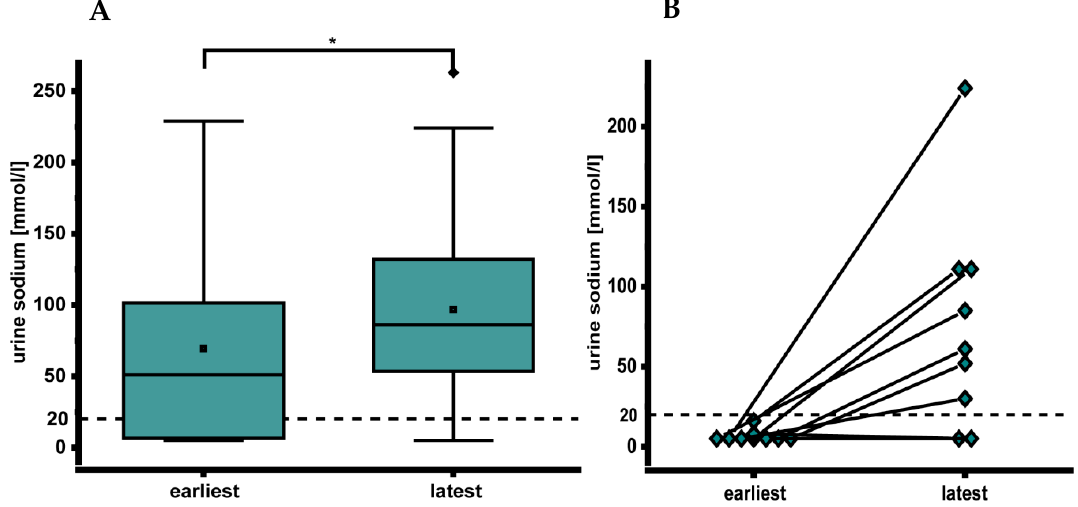
patients. In group 1, 11 patients had reconstructive surgery and 2 patients received teduglutide between MAX and LAST, they are indicated as red symbols and they are not included in the statistical analysis (median values and significant differences) at time point LAST. Median values are connected by the blue line. See text for details (* p < 0.05; ** p < 0.01; *** p < 0.001).